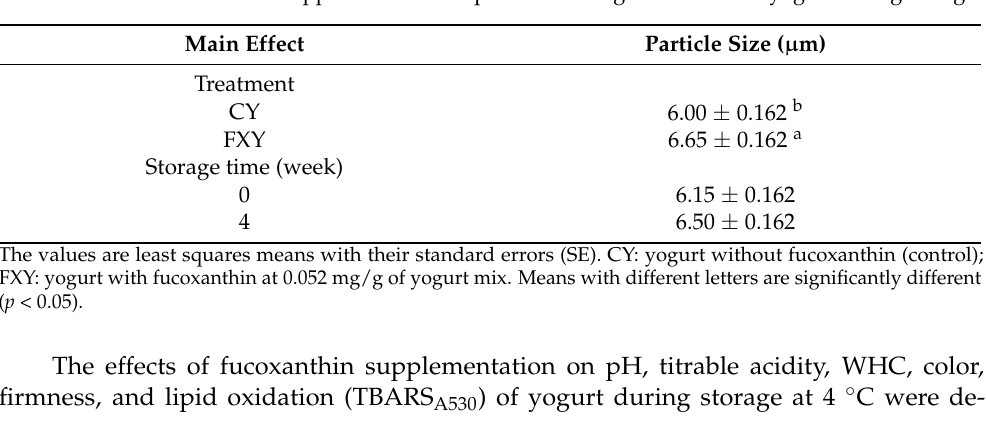
Table 4. Effect of fucoxanthin supplementation on particle size of goat whole milk yogurt during